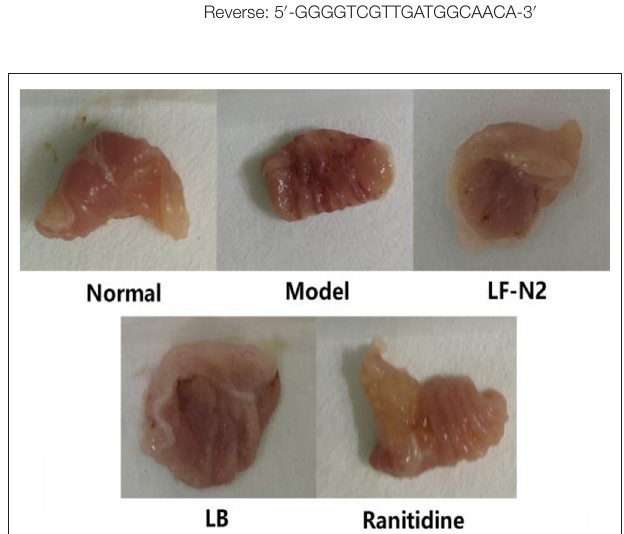
FIGURE 1 | Observation of gastric mucosa in mice. LF-N2, Lactobacillus fermentum TKSN02 (1 × 10 9 CFU//kg); LB, Lactobacillus bulgaricus (1 × 10 9 CFU/kg); ranitidine (200 µ